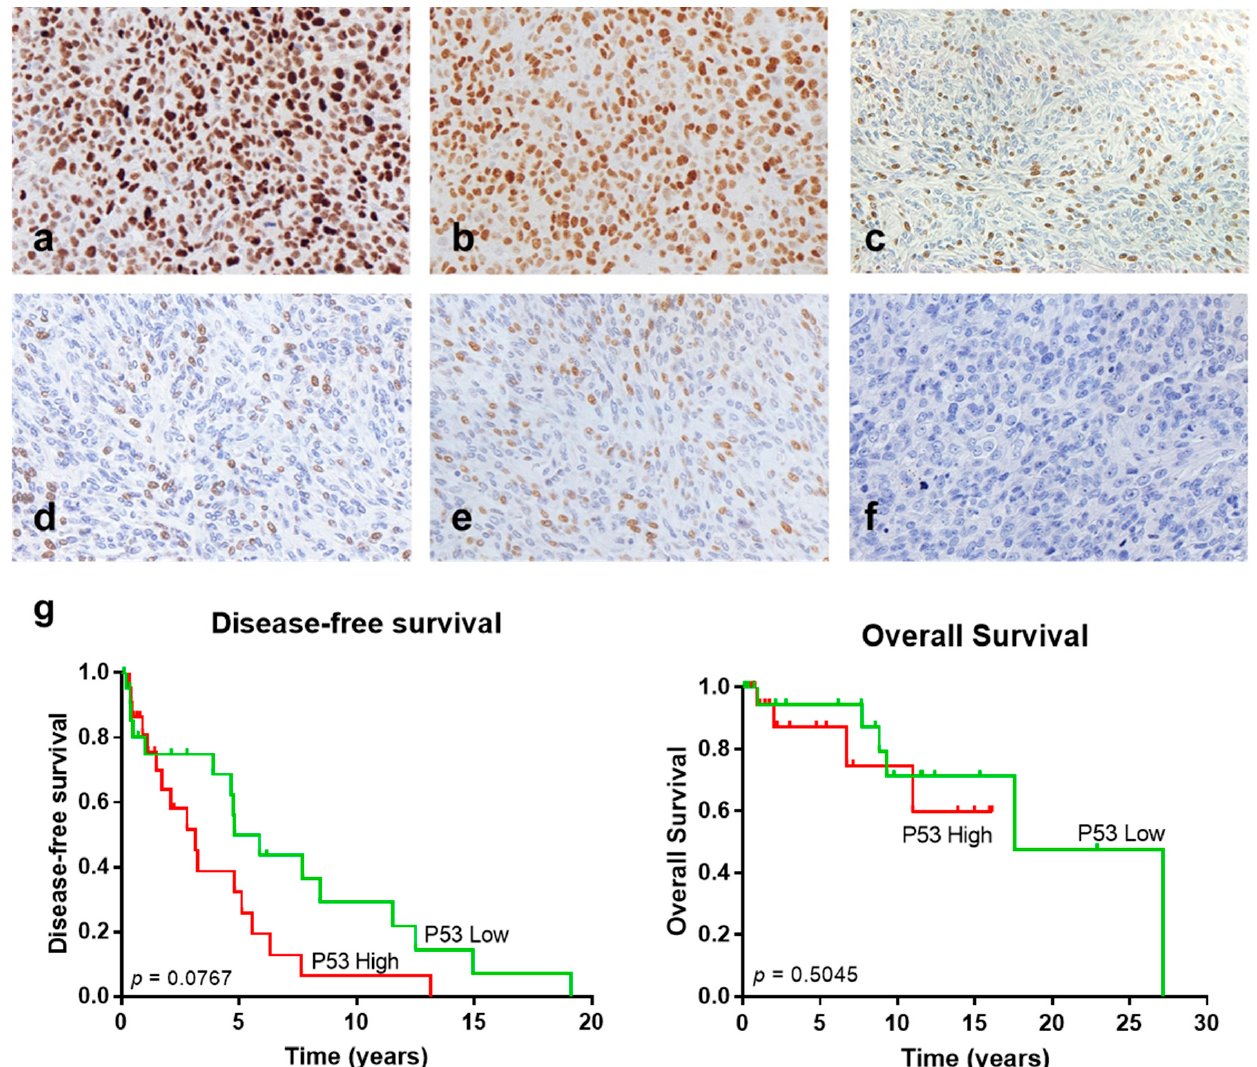
Figure 2. Immunohistochemistry of P53, BCOR, and pan-TRK in solitary fibrous tumors (SFTs). Representative images (40 × ) of high ( a ) and low ( d ) nuclear P53 staining; high ( b ) and low ( e ) nuclear BCOR staining and positive (nuclear) ( c ) and negative ( f ) pan-TRK staining. ( g ) Kaplan–Meier survival curves of disease-free survival ( left ) and overall survival ( right ) stratified based on P53 IHC staining in SFTs.